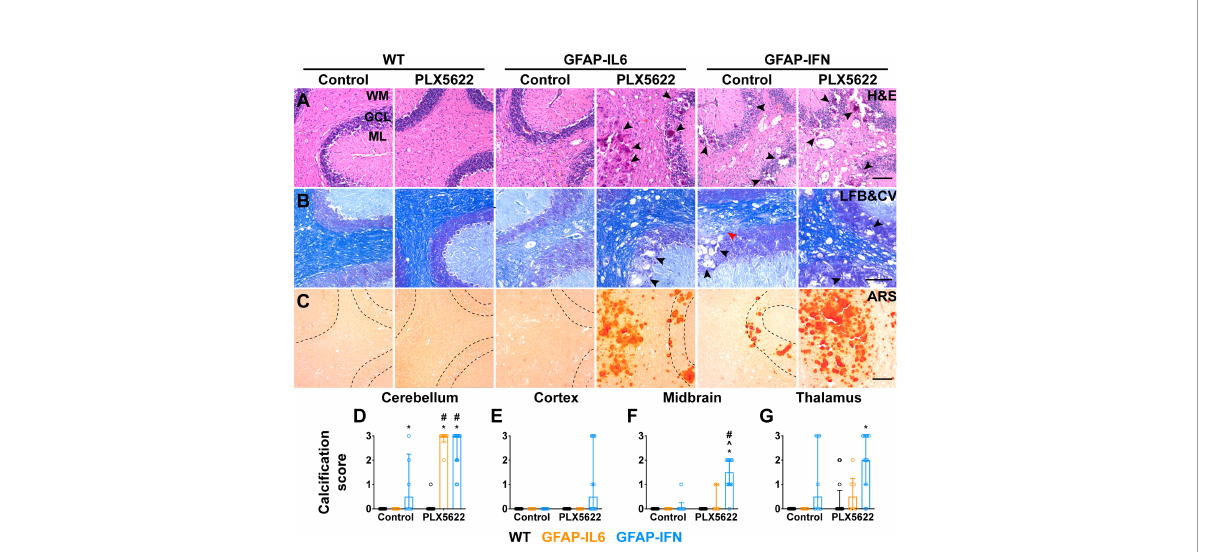
FIGURE 4 Exaggerated gross features of disease, with severe calci fi cation, in both GFAP-IL6 and GFAP-IFN mice treated with PLX5622. (A-C) Representative images of the cerebellum of mice treated with control or PLX5622 diet for 12 weeks. (A) Hematoxylin and eosin (H&E), (B) Luxol fast blue and cresyl violet (LFB&CV) and (C) Alizarin red S (ARS) stains. WM: white matter, GCL: granule cell layer and ML: molecular layer. Black arrowheads indicate calci fi ed deposits and red arrowhead indicates area with focal demyelination. Scale bars, 100 m m. (D-G) Calci fi cation scores in the (D)